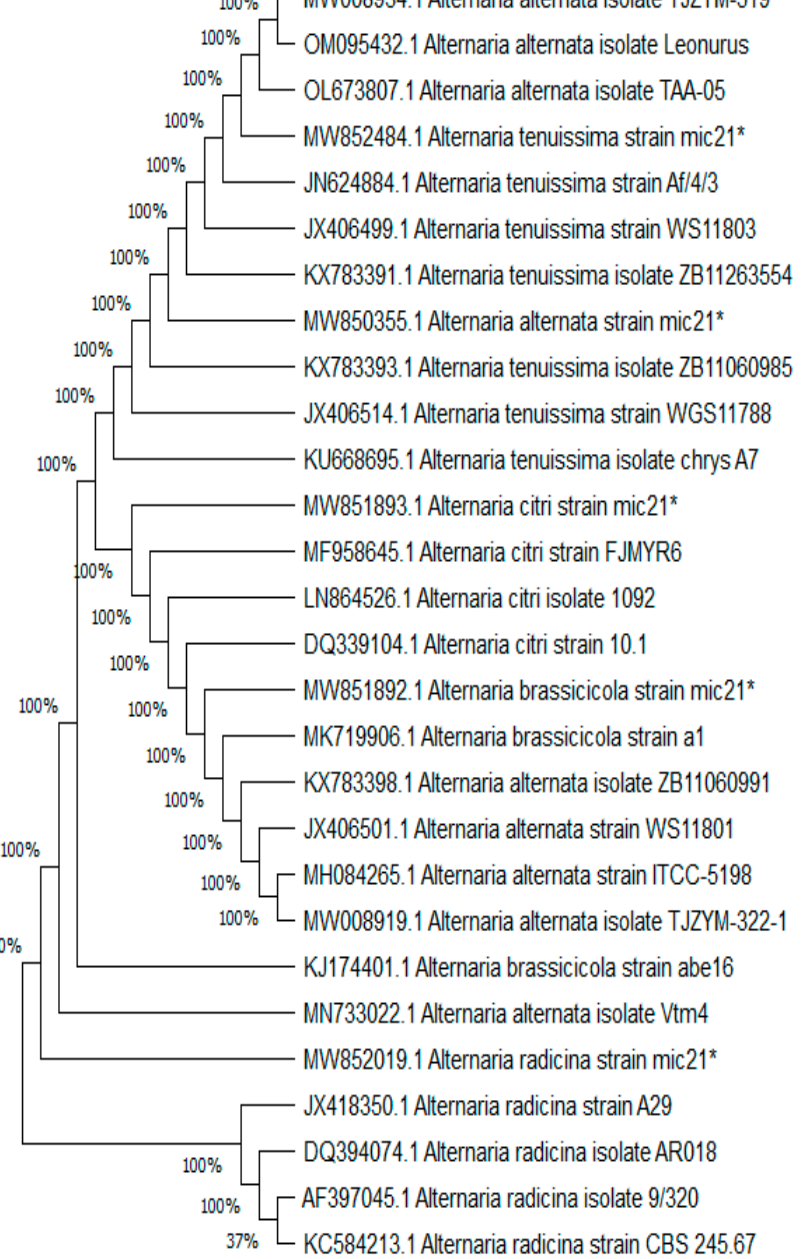
Figure 3. Phylogenetic tree generated from Alternaria species and its related species/isolates based on datasets of ITS rDNA gene sequences. There is similarity of 99–100% among species. Alternaria isolates with a star were recovered from tomato fruits in this study.